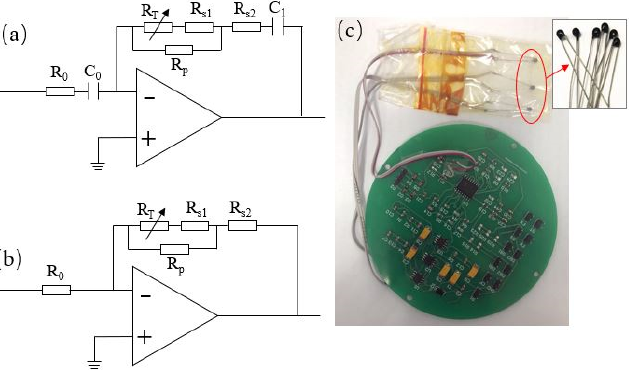
Figure 8. The flowchart for the closed-loop system with temperature compensation.